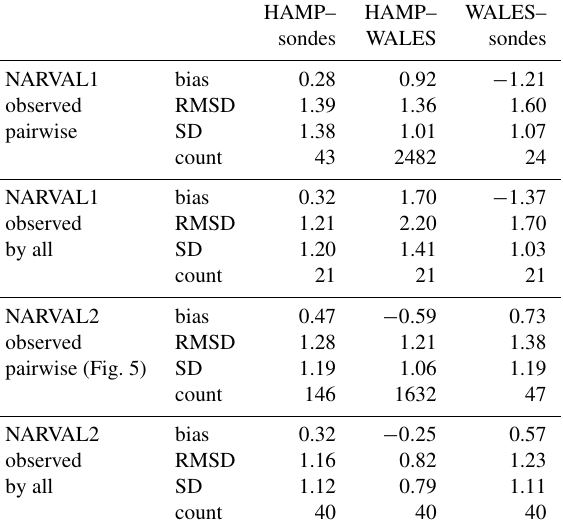
Table 2. Comparison of IWV retrieved from HAMP, WALES, and dropsondes. Pairwise observations of two instruments and the sub- sets of the observations for that all instruments were available. Bias, root-mean-square deviation (RMSD), and bias-corrected RMSD (standard deviation, SD) in kilograms per square meter (kgm − 2 ). Observed by all implies only small or no clouds. HAMP– HAMP– WALES– sondes WALES